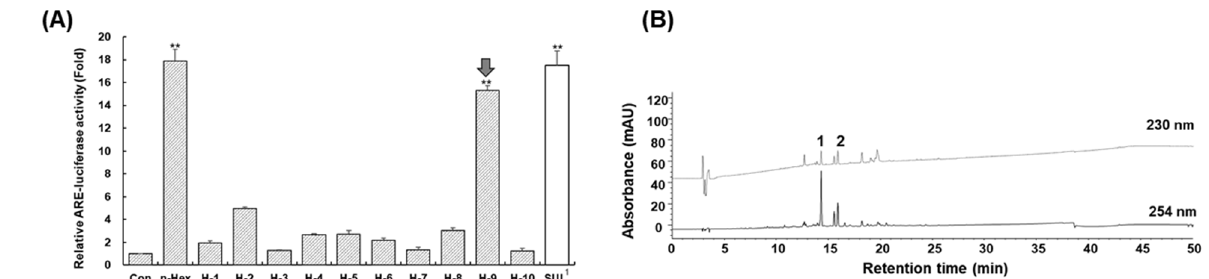
Figure 3. The relative antioxidant response element (ARE)-luciferase activities ( A ) of the CPC-fractions H1H10 and HPLC chromatogram ( B ) of active fraction H9 . The ARE induction activities were evaluated in ARE-HepG2 cells at concentrations applied at each assigned weight ratio (based on 30 μ g/mL of crude extract). Data are presented as the mean ± S.E. ( n = 3). ** p < 0.01 (compared with the vehicle-treated control). 1 Sulforaphane was treated 5 μ M as positive control.